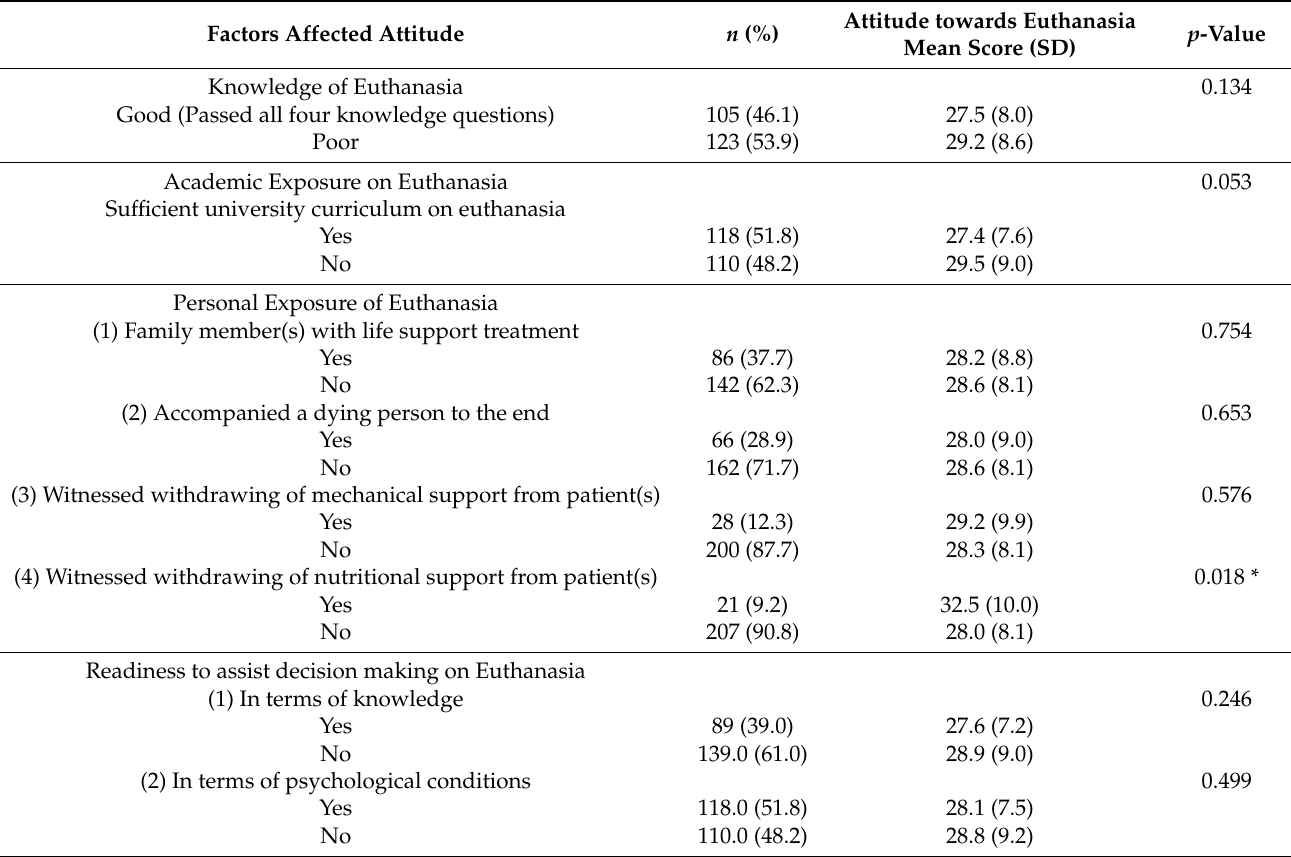
Table 2. Univariate Analysis of KAP ( n =